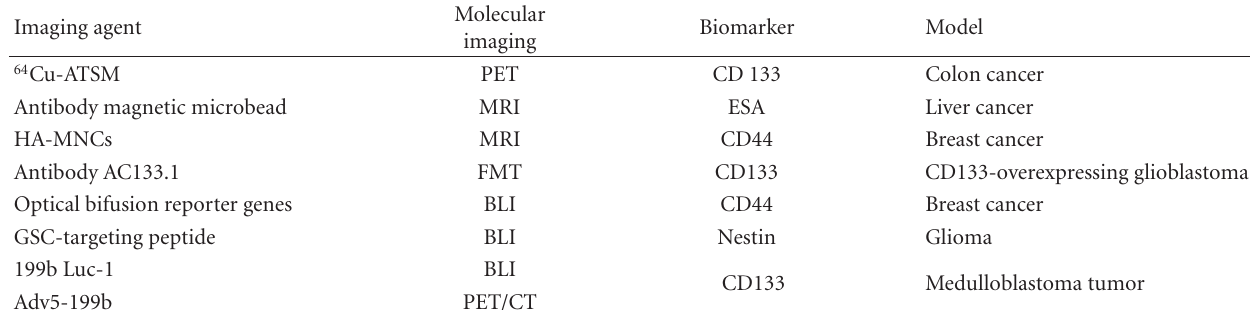
Table 2: Molecular imaging in tracking tumor stem-like cells.